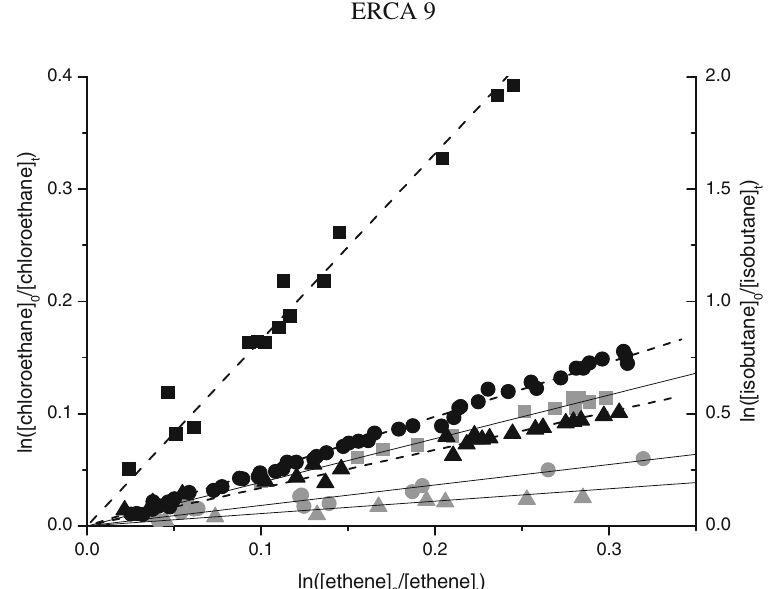
Fig. 7. Plots of ln([reference] 0 / [reference] t ) versus ln([ethene] 0 / [ethene] t ) obtained with FTIR. Dashed lines with black symbols, and solid lines with gray symbols indicate measurements using isobutane and chloroethane as the reference, respectively. Triangles, circles, and squares correspond to measurements at 1000, 400, and 100mbar,